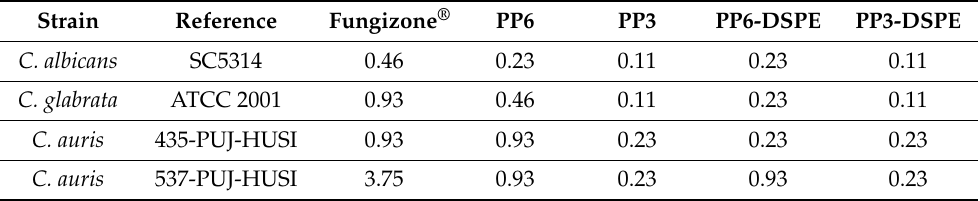
Table 4. MIC ( µ g/mL) of AmB-loaded copolymers and commercial formulation.